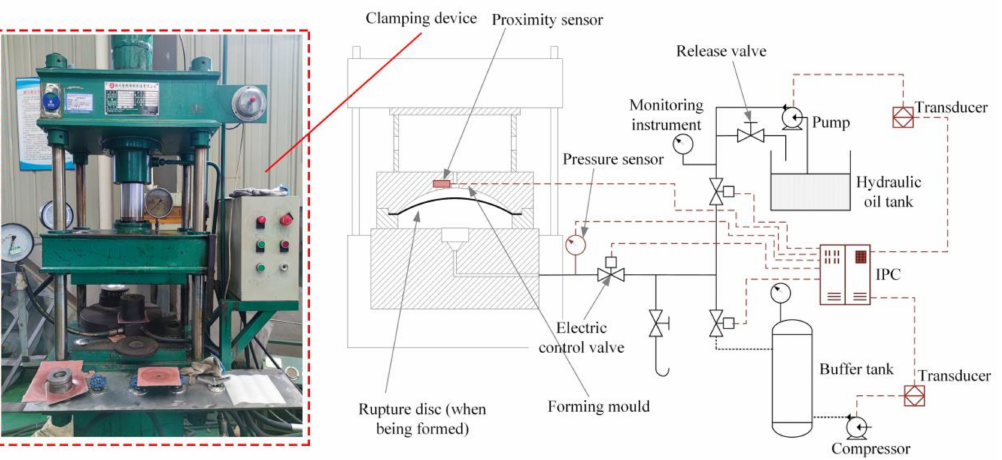
Figure 4. Manufacturing equipment for rupture